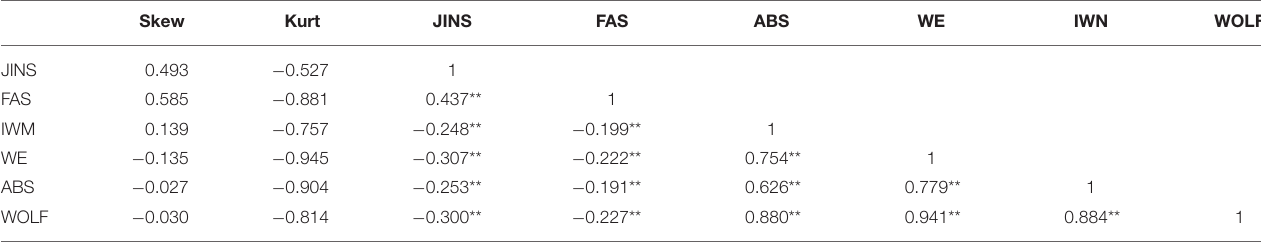
TABLE 3 | Product-moment correlation